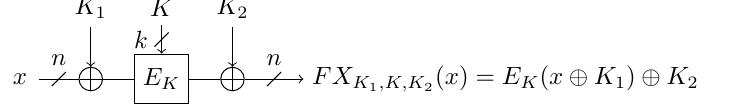
Figure 3: The FX construction. E K is a block